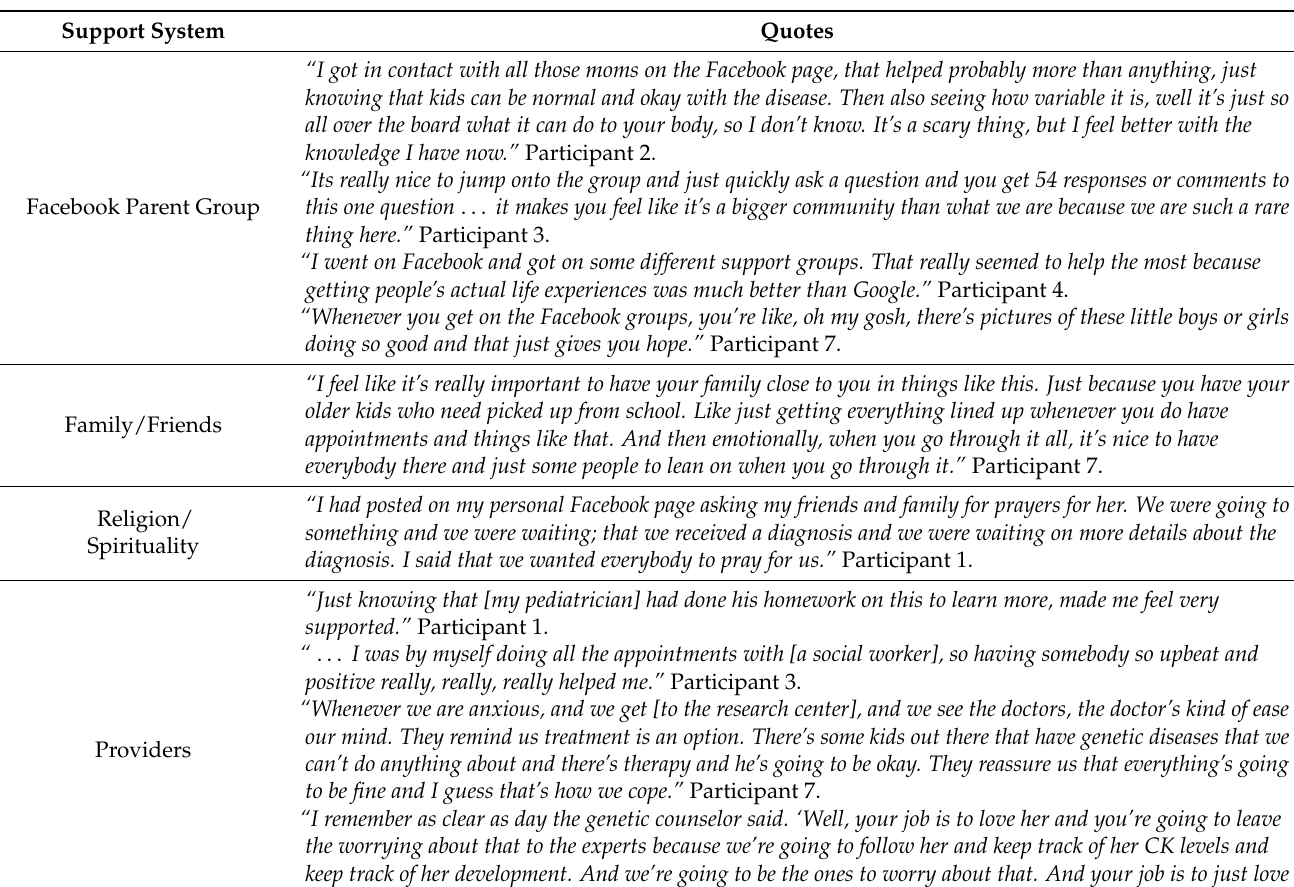
Table 7. Support systems reported by participants through diagnosis period and